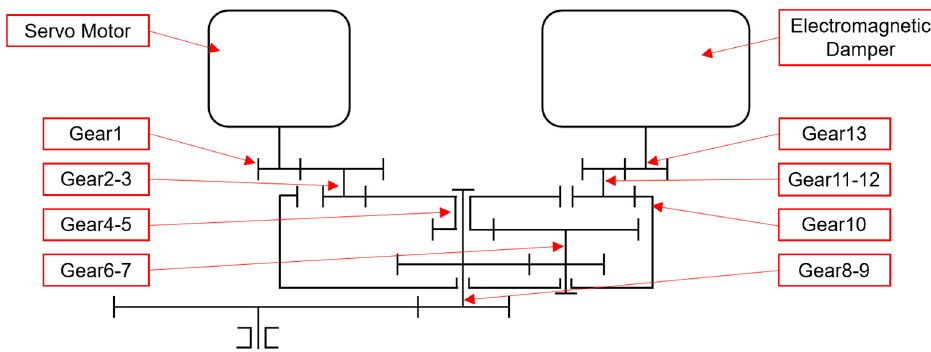
Figure 5. Schematic diagram of the gear reducer.